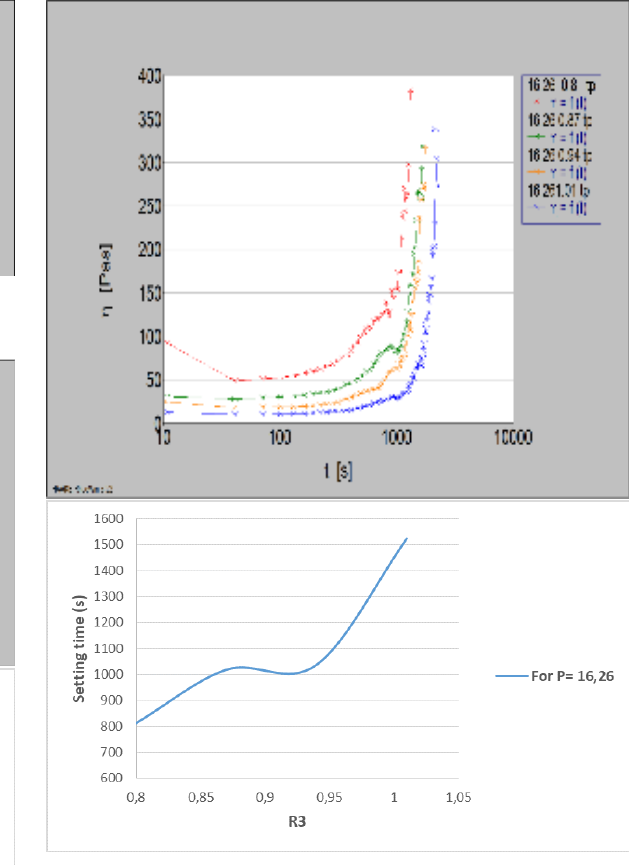
Figure 15: Evolution of the setting time for a different L/S and for P= 16.26%